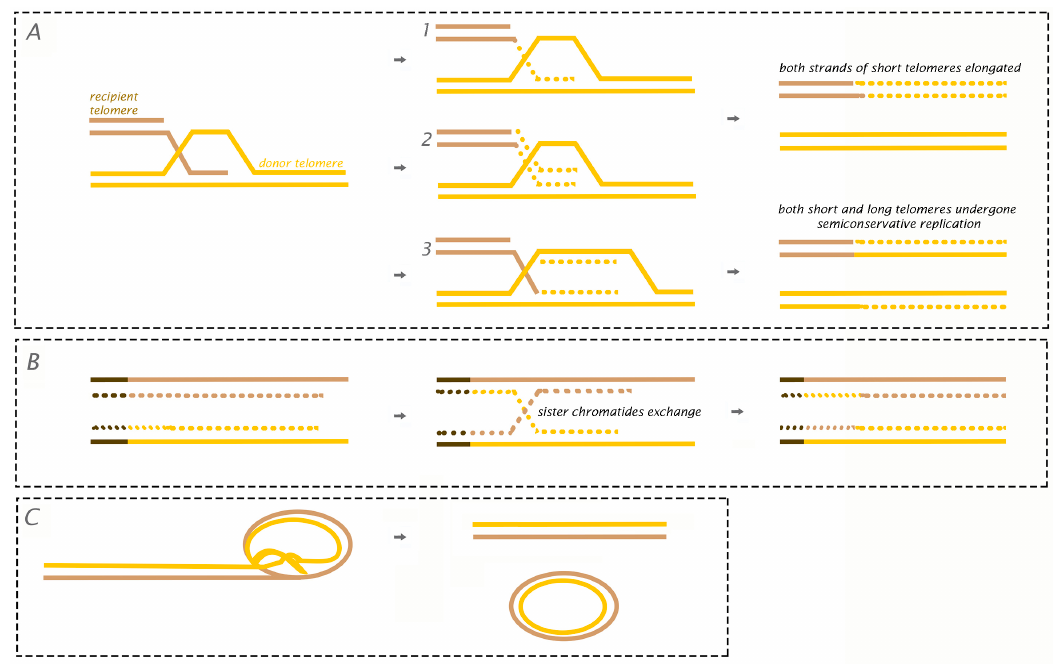
Figure 1. Theoretical models for ALT mechanism: ( A ) Break ‐ induced replication loss from the donor telomere (1 and 2 without loss from the donor telomere). In Model 3, there is a unidirectional replication fork with semi ‐ conservative replication of the telomeres. ( B ) Unequal telomeric sister chromatid exchange (T ‐ SCE) model. ( C ) Rolling circle and t ‐ circle formation after t ‐ loop resolution providing a linear double strand break for subsequent HR ‐ mediated activation into the homologous templates. Adapted from [62].